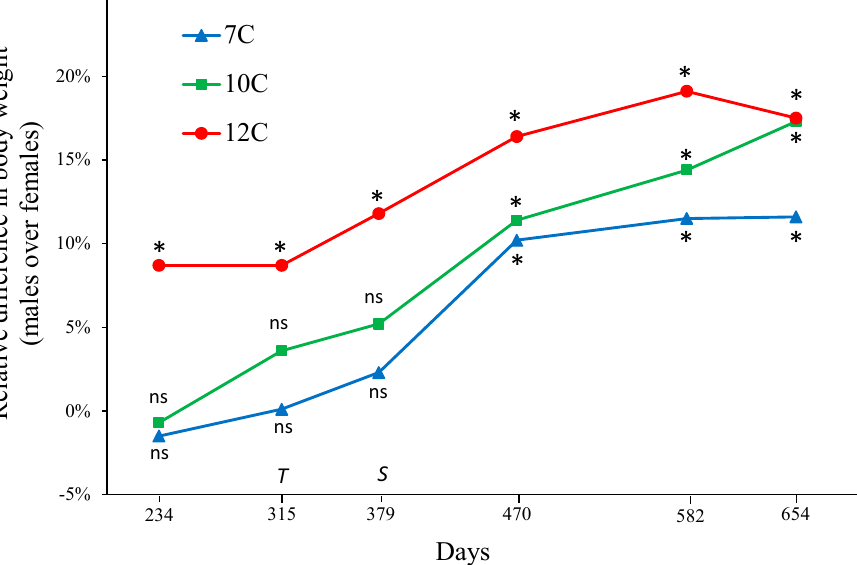
Figure 2. Body weight (W) progression of Arctic charr males relative to their female counterparts from tagging on day 234 until harvest on day 654. From day 0 until day 315 the groups were reared at three target temperatures, 7C ( ▲ ), 10C ( ■ ), and 12C ( ● ). On day 315 all groups were acclimatized to 7 °C ( T ) and reared at 7–8 °C until harvest on day 654. On day 379 all groups were subjected to a salinity change from 4 to 22 ppt ( S ). Asterisks indicate significant differences in W at the 5% level of significance. Non-significant differences in W are indicated (ns).